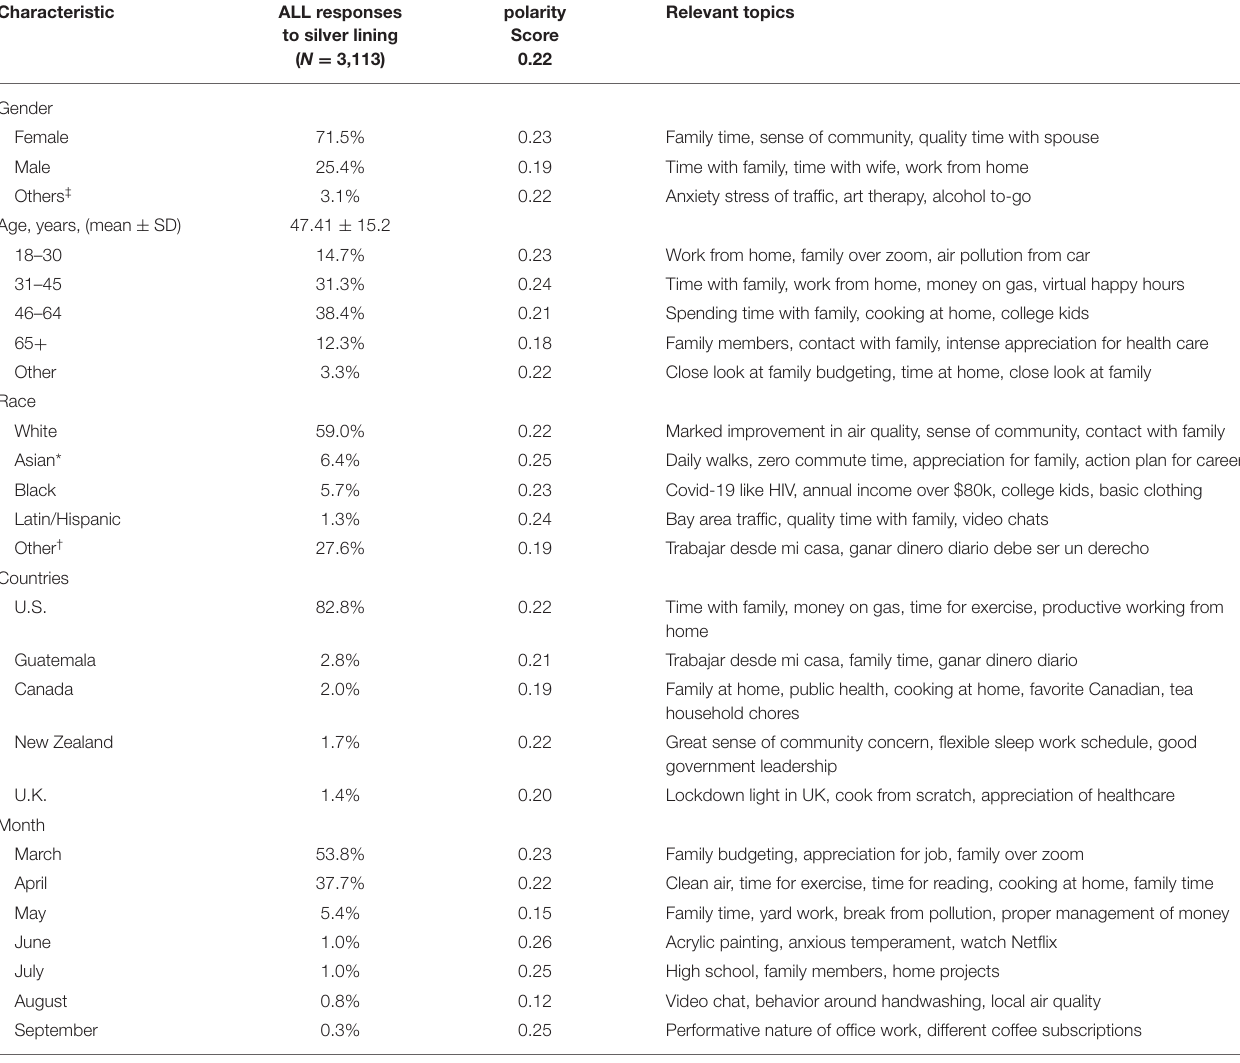
TABLE 1 | Participant demographics and sentiment analysis results (18 < = age < = 99).